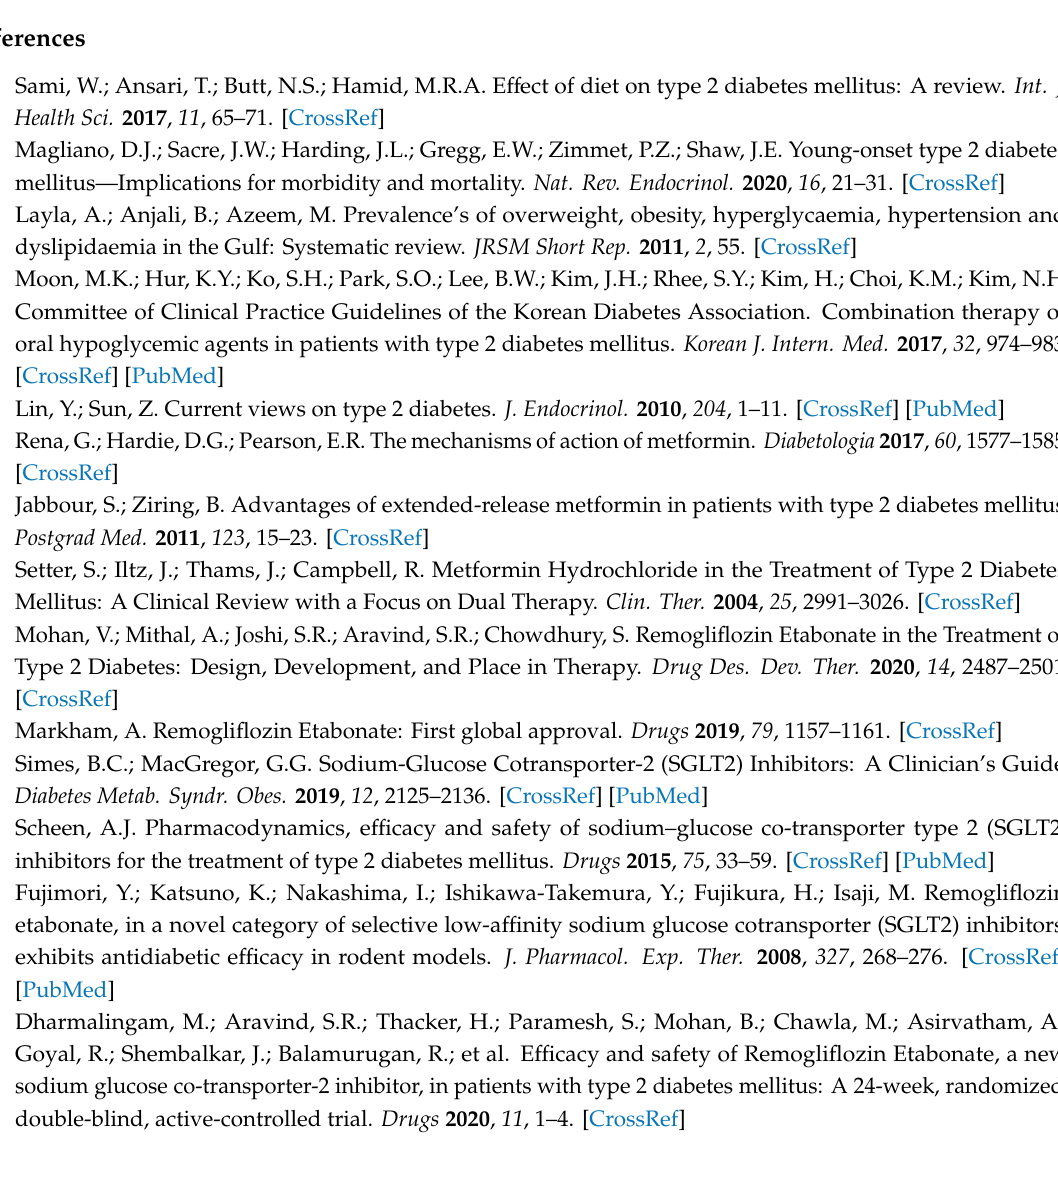
Figure S1. Chromatograms of standard solutions of metformin and remogliflozin (MFH:RGE ( µ g / mL) = 25:5 (A); 50:25 (B), 75:50 (C); 100:75 (D); 125:100 (E); 150:125 (F); to 200:150 (G) and samples 100:10 (H) and 200:20 (I). Figure S2. Calibration curves for RGE and MFH by second-derivative UV spectroscopic method. Figure S3: Calibration curves for RGE and MFH by RP-HPLC method. Figure S4. Normal and second-derivative UV spectra of MFH and RGE for accuracy and precision, laboratory mixed solutions, and formulations. Table S1. Results of the Box–Behnken model for robustness